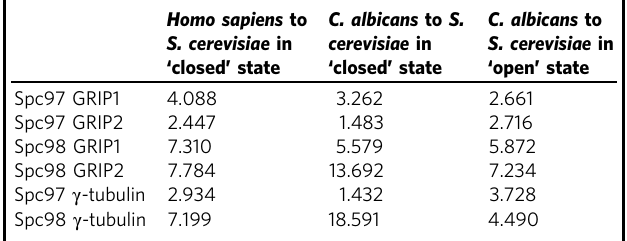
Table 3 R.M.S.D. of C α backbone atoms between γ -TuSC segments in different overall